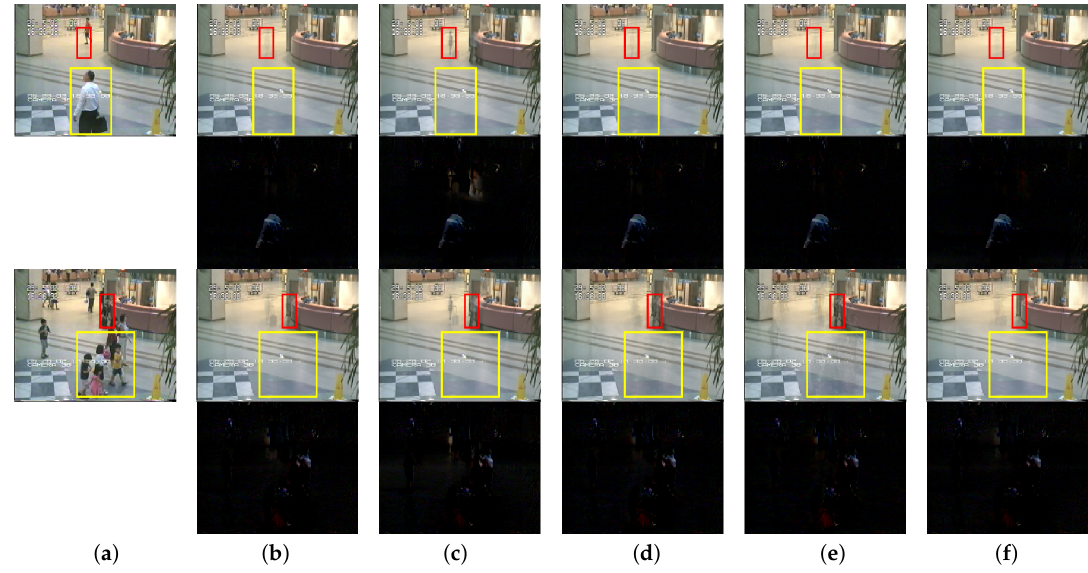
Figure 3. Background modeling: two example frames from Hall sequences are shown. ( a ) Original; ( b ) RPCA [4]; ( c ) Gamma [26]; ( d ) SNN [49]; ( e ) TRPCA [20]; ( f )